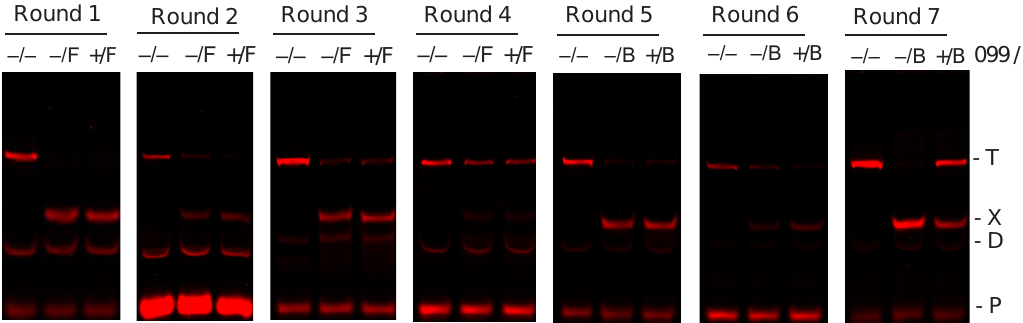
Figure 1. Selection of TTHB099-binding DNA sequences. Shown are IR fluorescence images of restriction endonuclease cleavage-protection assays made during Rounds 1–7 of REPSA selection with 50.6 nM TTHB099 protein. The presence ( + ) or absence ( − ) of TTHB099 and IISRE FokI (F) or BpmI (B) are indicated above each lane. The electrophoretic mobility of the intact (T) and cleaved (X) ST2R24 selection template, primer dimer species (D), as well as the IRD7_ST2R primer (P) are indicated at the right of the figure.